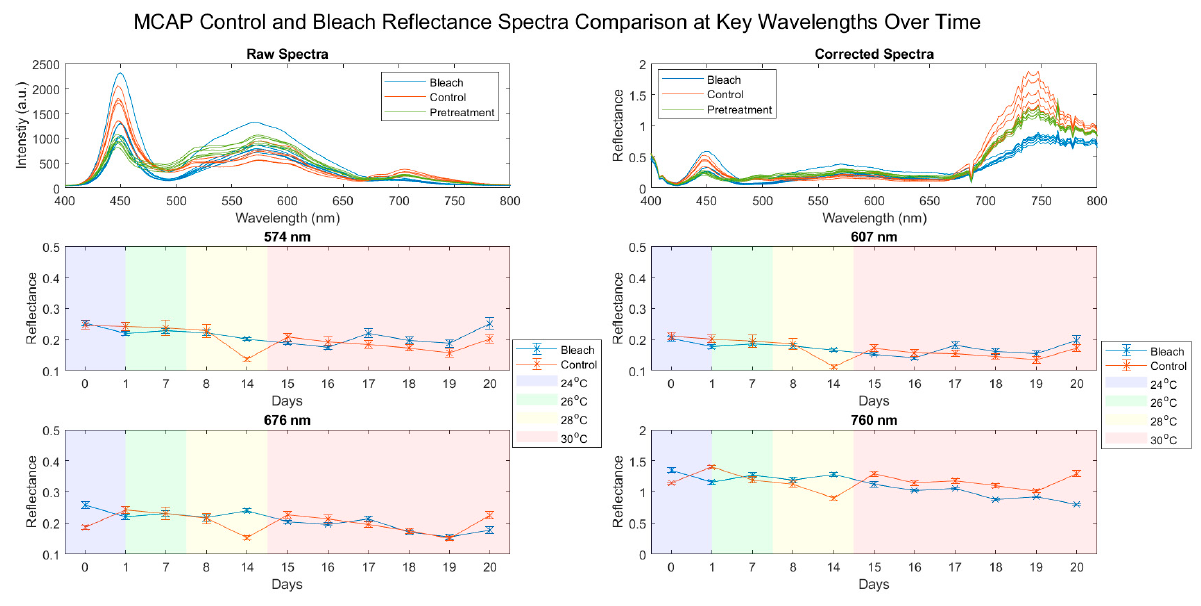
Figure 2. Raw & corrected reflectance spectra and reflectance of key wavelengths of Montipora capricornis (MCAP) over time imaged under white light in experiment 1. The average intensity at each wavelength per day of treatment is presented, where the temperature regime is represented as the blue section corresponding to 24 °C (the control stayed at this temperature throughout), green to 26 °C, yellow to 28 °C and red to 30 °C.